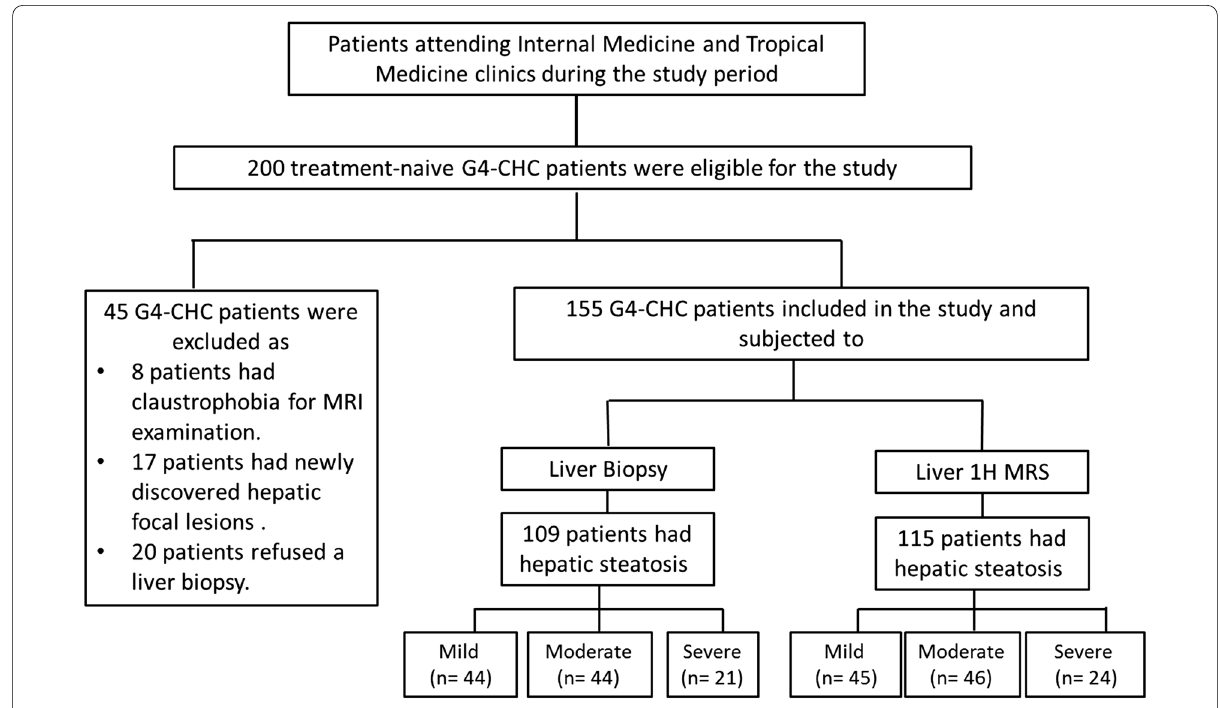
Fig. 1 Low chart of the patients enrolled in the present